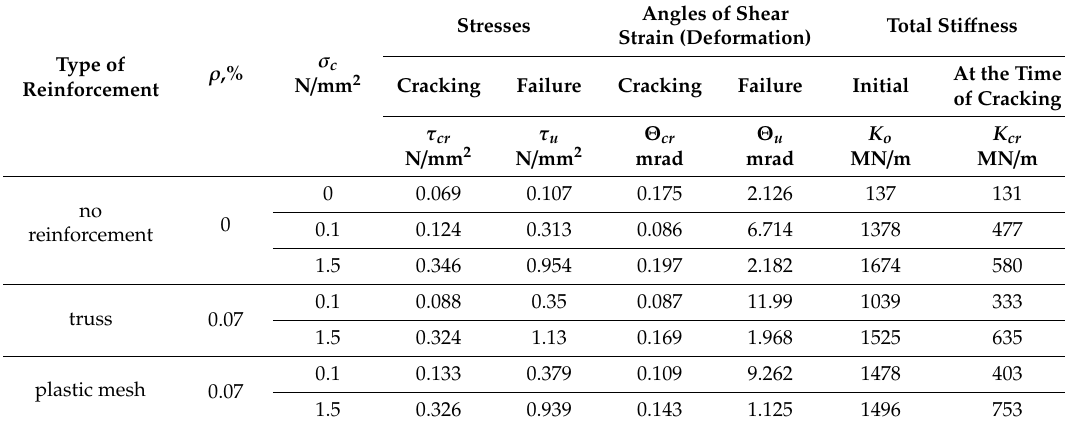
Figure 12. Relationships τ - Θ for unreinforced and reinforced units made of silicate masonry units tested at di ff erent values of initial compressive stress: ( a ) σ c = 0.1 N / mm 2 and ( b ) σ c = 1.5 N / mm 2 . Table 5. Test results for walls made of silicate masonry units.